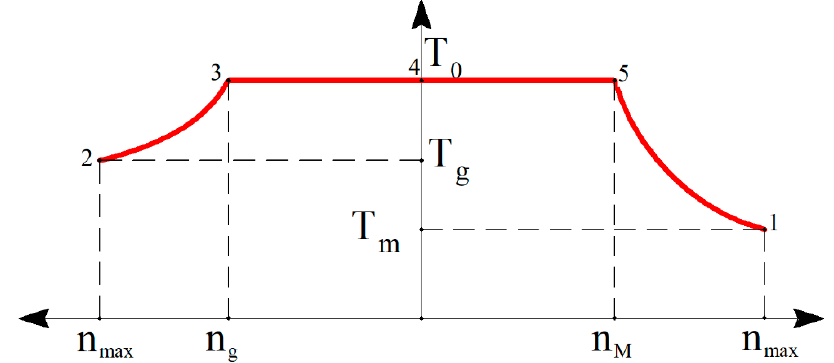
Figure 4. Demanded speed-torque curve of the subway traction drive.